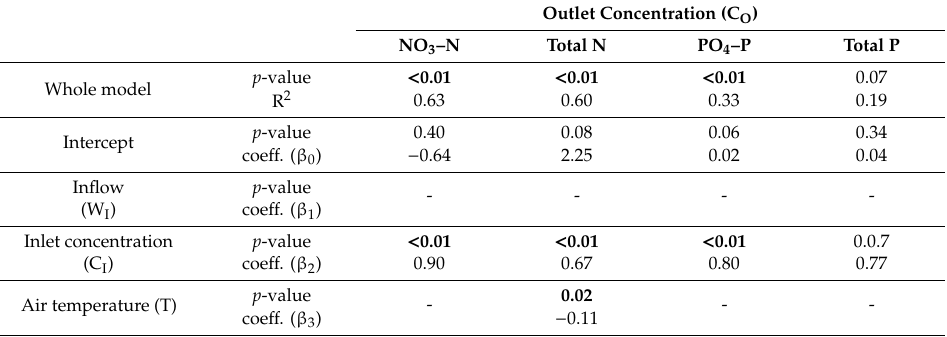
Table 5. Parameters of the selected models per each nutrient form. Whole model parameters ( p -value and R squared) and predictors parameters ( p -values and regression coe ffi cients) are reported. p -values < 0.05 are in bold. Expressions in parentheses refer to Equation (4). Concentrations (monthly flow-weighted) are in mg L − 1 ; air temperature (monthly average) in ◦ C, inflow (monthly volumes) in 10 3